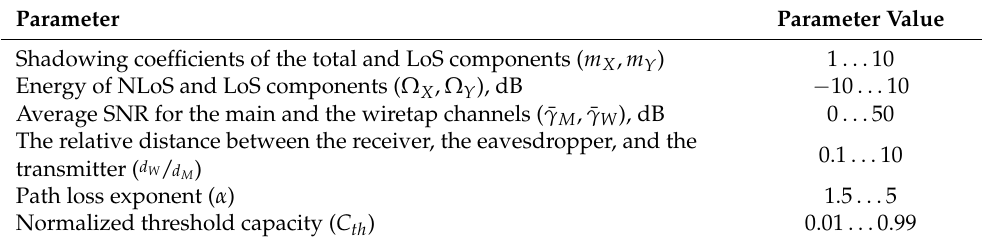
Table 3. System and channel parameters assumed for